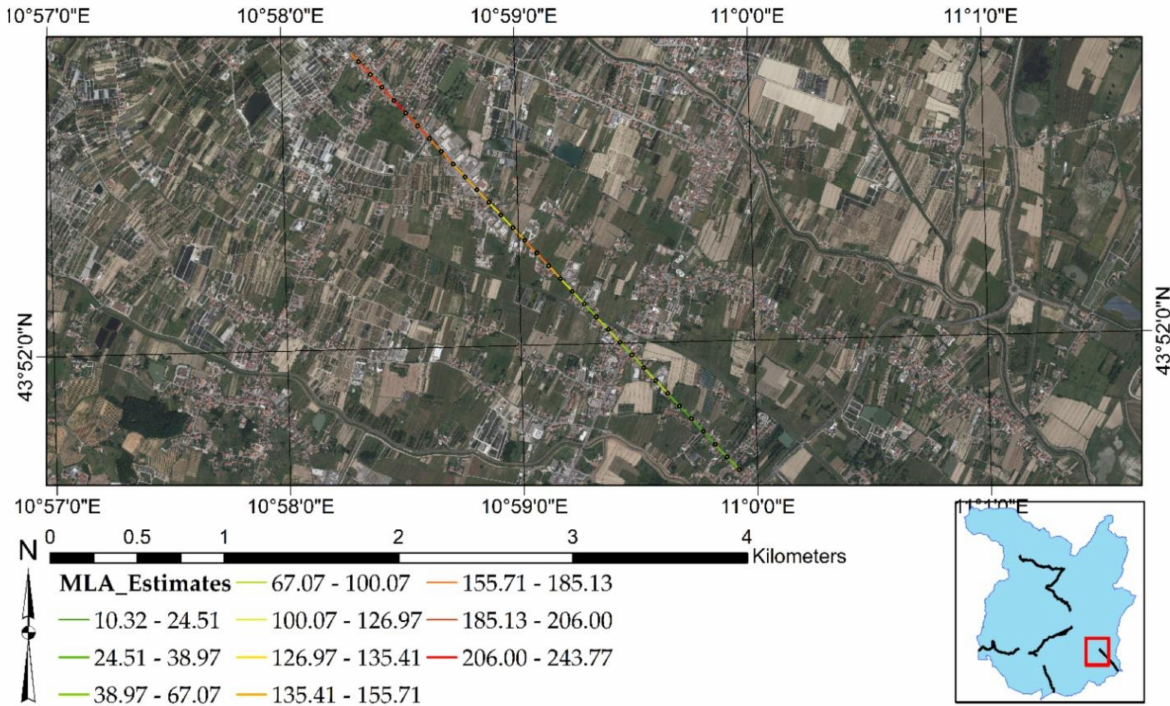
Figure 14. Normalized weighted sum of the absolute value of ML predictions: test site